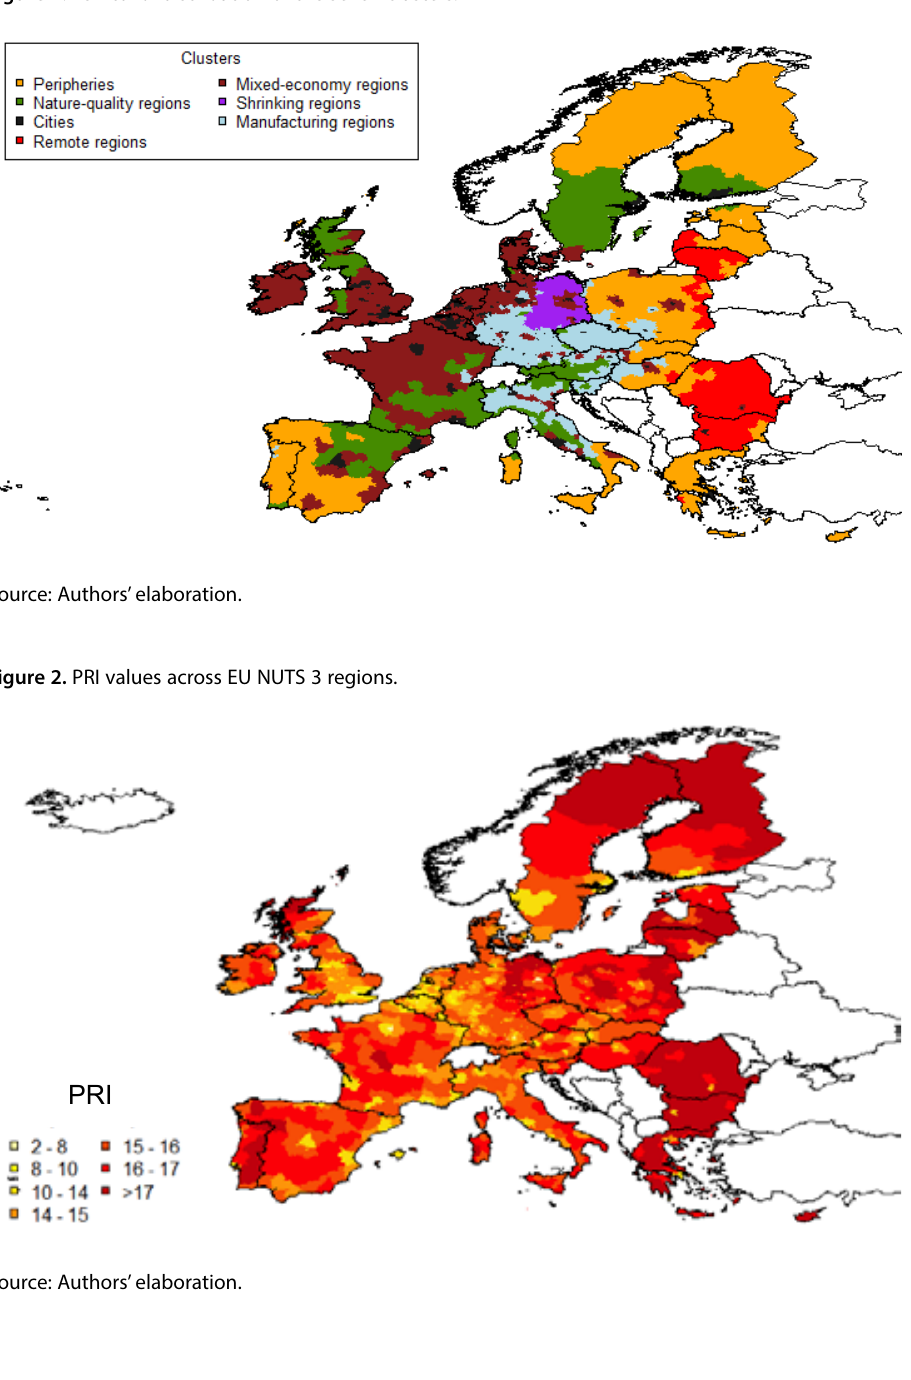
Figure 1. Territorial distribution of the seven clusters.